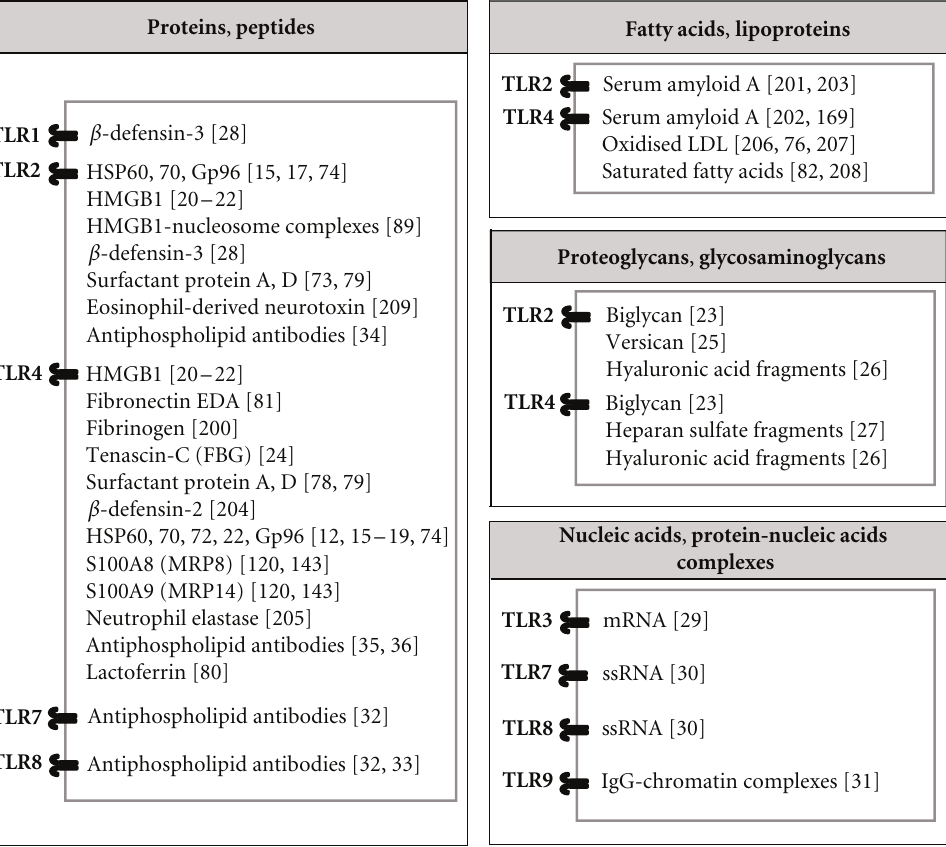
Figure 1: Endogenous TLR activators . TLRs are activated by damage-associated molecular patterns (DAMPs) including intracellular molecules released in the extracellular milieu by activated or necrotic cells and extracellular matrix molecules either upregulated upon injury or degraded following tissue damage. Known endogenous TLR activators are listed based on their biochemical nature. of LPS [53]. This suggests that even minor modifications